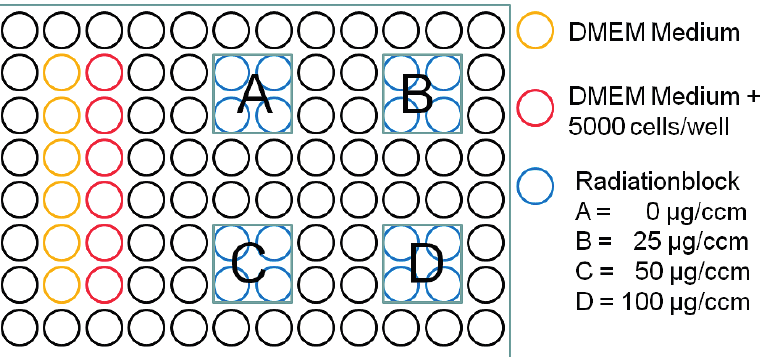
Figure 5. 96 well microplate